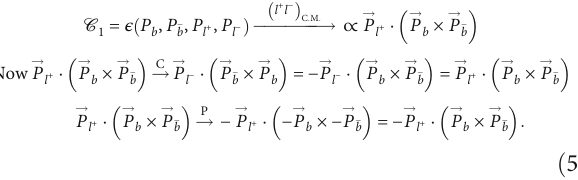
Figure 5: d vs. Λ for observable C g